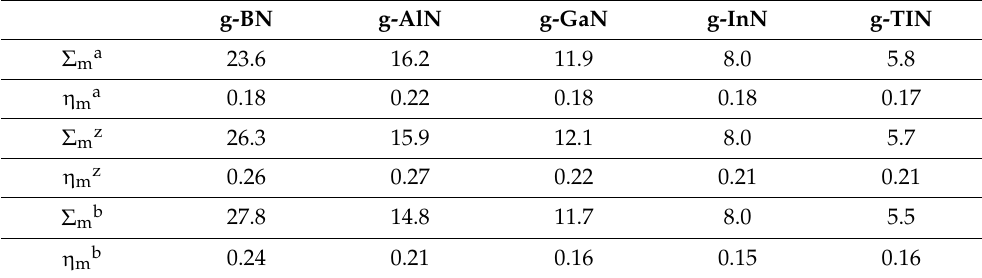
Table 2. Ultimate strengths ( Σ ma , Σ mz , Σ mb ) in units of N m − 1 and ultimate strains ( η ma , η mz , η mb ) under uniaxial strain (armchair and zigzag) and biaxial strain from DFT calculations, compared with g-BN, graphene, and graphyne. g-BN g-AlN g-GaN